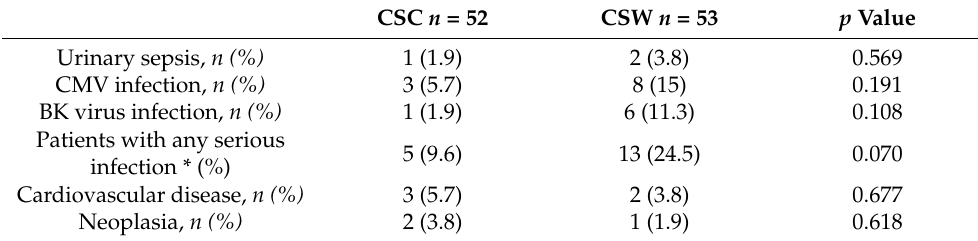
Table 8. Serious adverse events during the follow